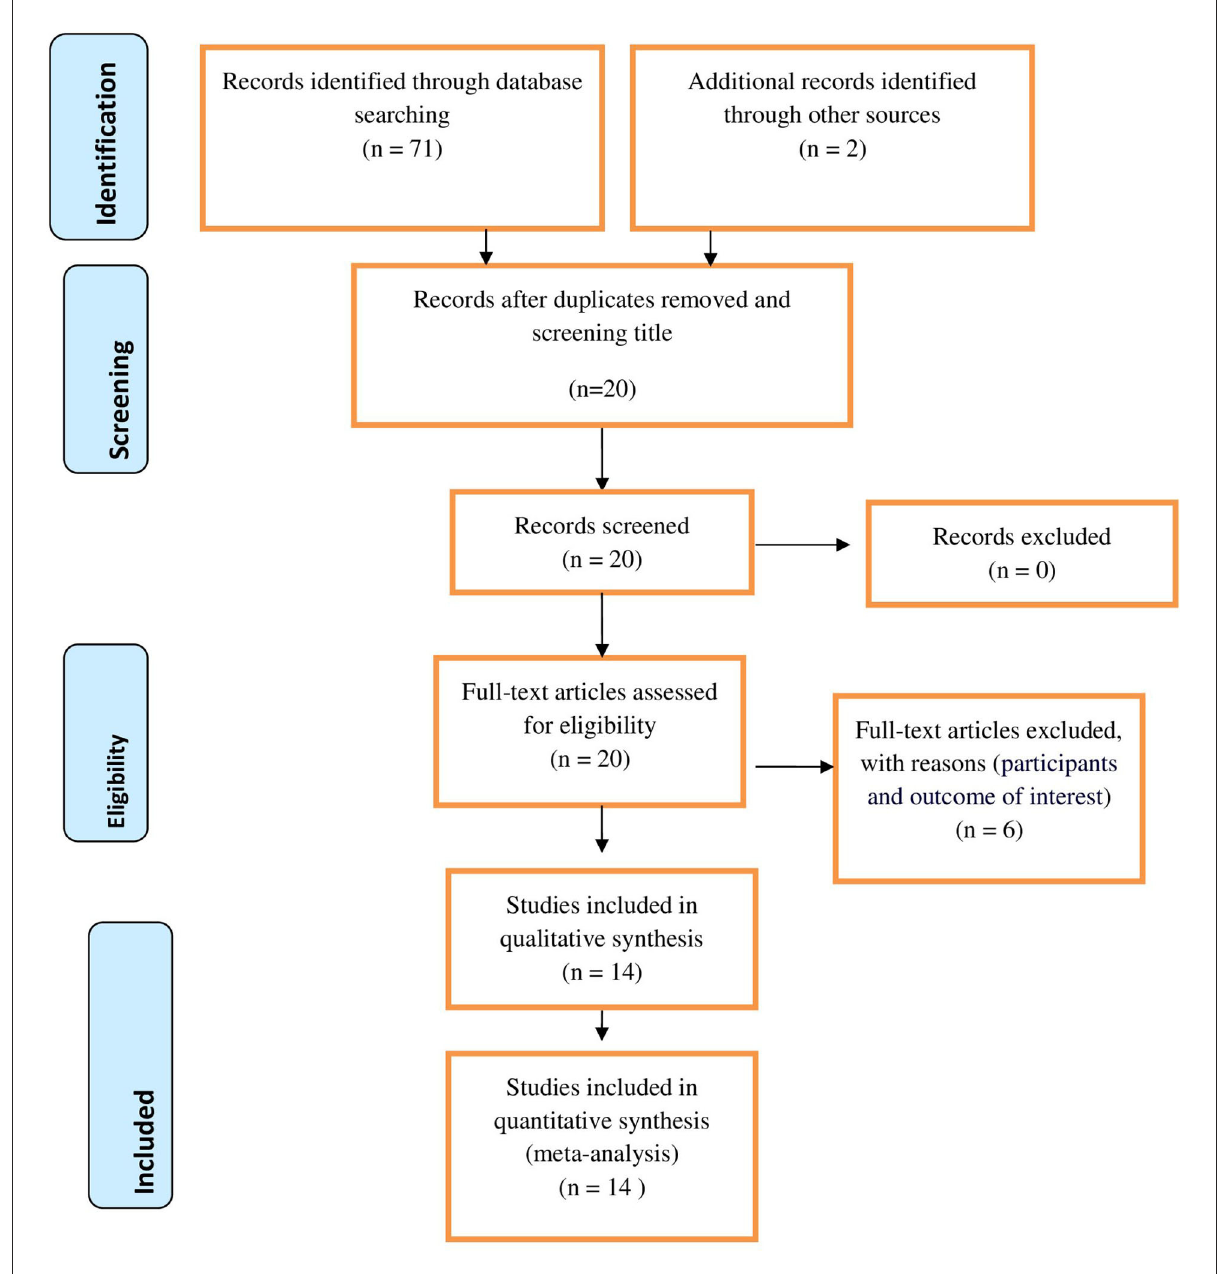
FIGURE1 PRISMA flow diagram of included studies for the systematic review and meta-analysis of disclosure status and associated factors among Women in East Africa, 2021.